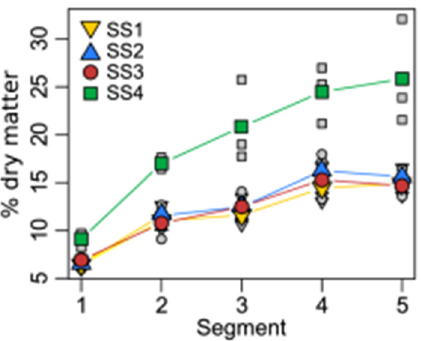
Figure 2. Dry/fresh weight ratio in the five 1 cm apical segments of F. antipyretica samples from the four sampling stations (SS). Segments are numbered from 1 to 5, starting at the shoot tip. The colored symbols are the means of the three replicates of the SS × segment combinations.